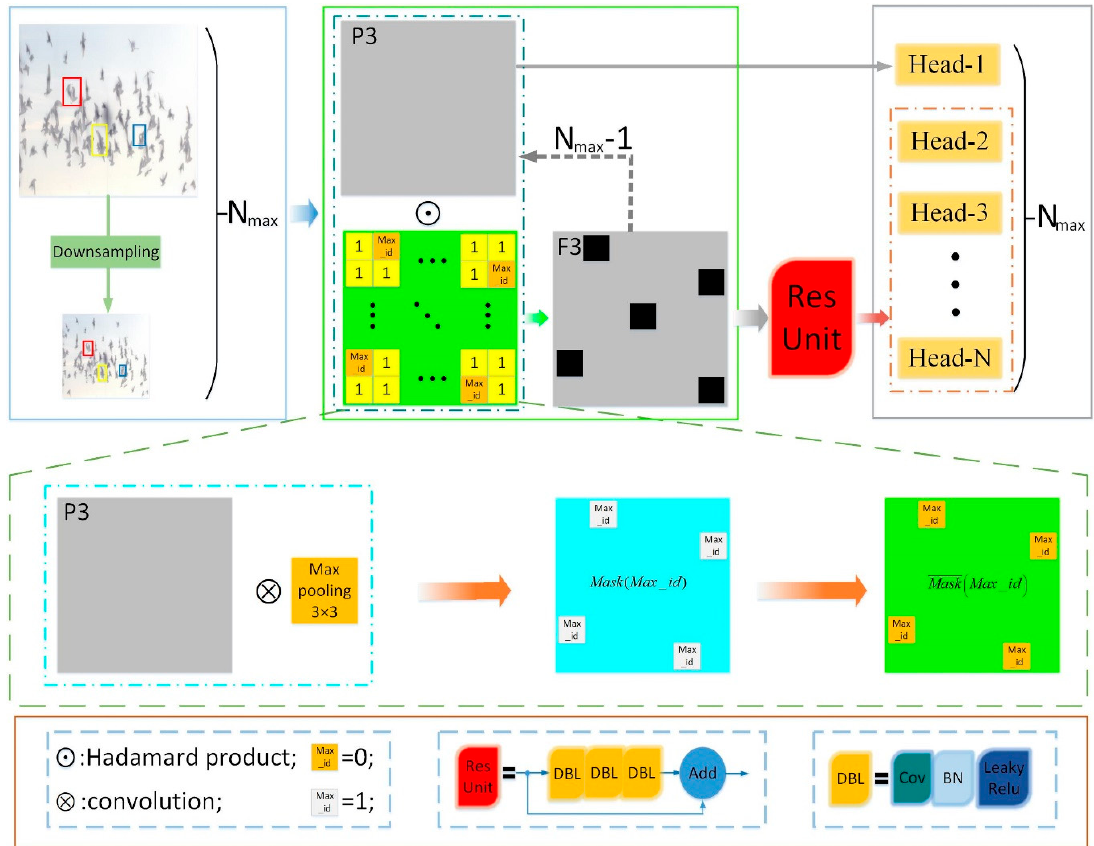
Figure 5. Workflow of differentiation module. The differentiation module mainly includes 3 steps. The output result is composed of N max